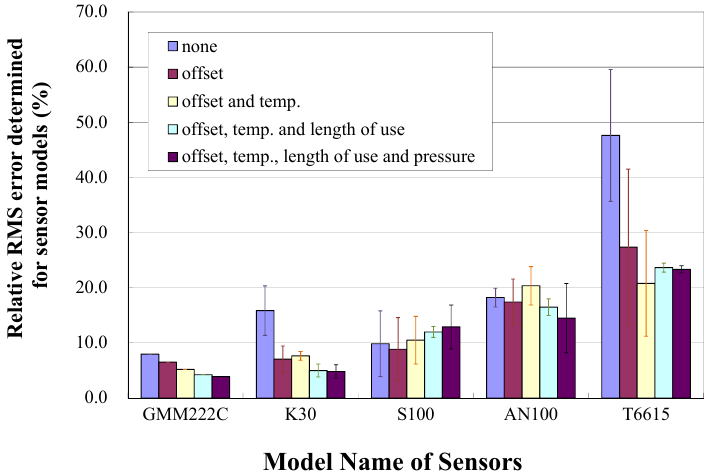
Figure 6. Average RRMS errors using coefficients determined for sensor